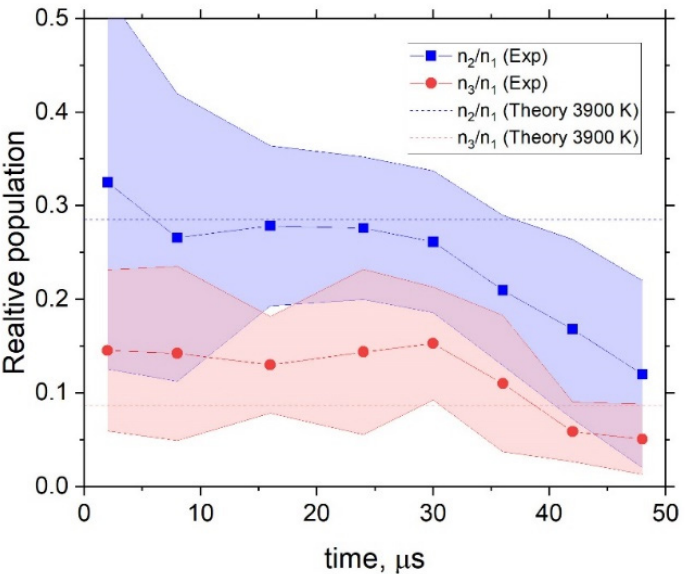
Figure 12. Populations of OH of v = 2 and v = 3 relative to the population of v = 1, assuming T R = 500 K. The dash lines indicate the estimated relative populations for the vibrational temperature of T vib = 3900 K.